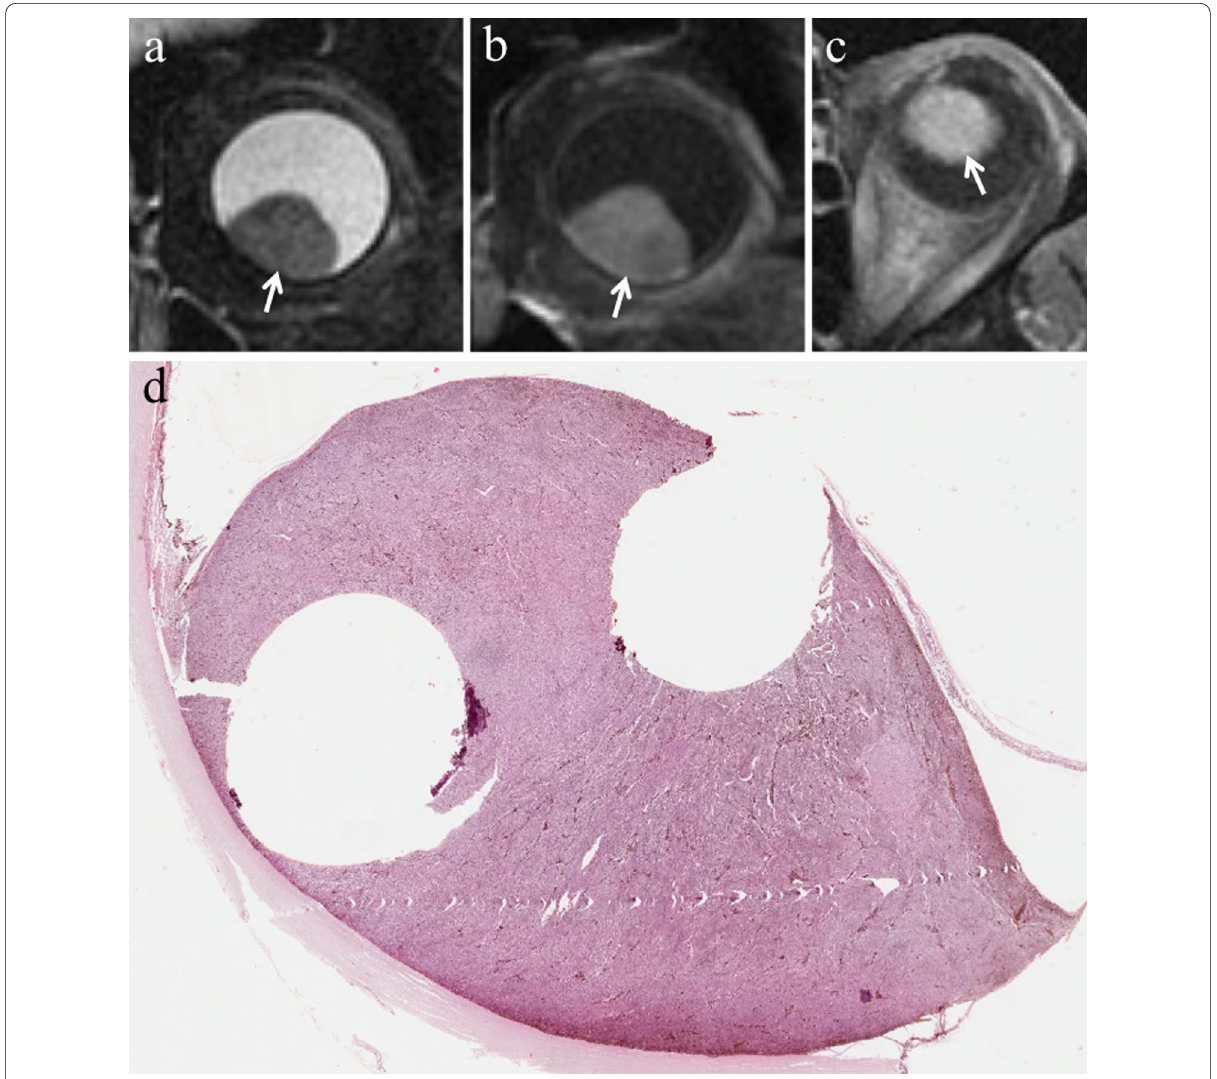
Fig. 12 A 81-year-old woman with a dome-shaped choroidal melanoma of the left eye. ( a ) Coronal T2-weighted turbo spin-echo STIR image demonstrates an intraocular mass along the infero-medial aspect of the globe (white arrow). On ( b ) coronal and ( c ) axial contrast-enhanced fat-suppressed T1-weighted images the lesion displays enhancement (white arrows). ( d ) Histological examination displaying a protruding moderately pigmented mass with well circumscribed borders located in the posterior segment of the eye (H&E, original